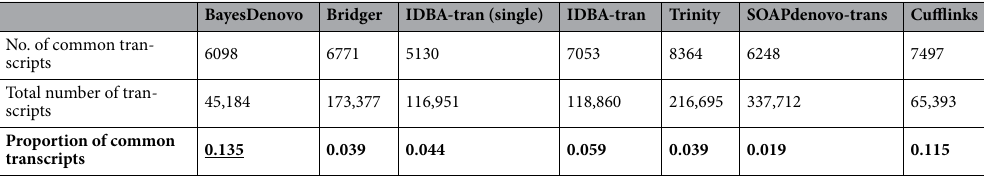
Table 2. Comparison of consistency across three biological replicates. Bold numbers show the metric where BayesDenovo significantly outperforms existing methods. Bold underline numbers highlight the performance of